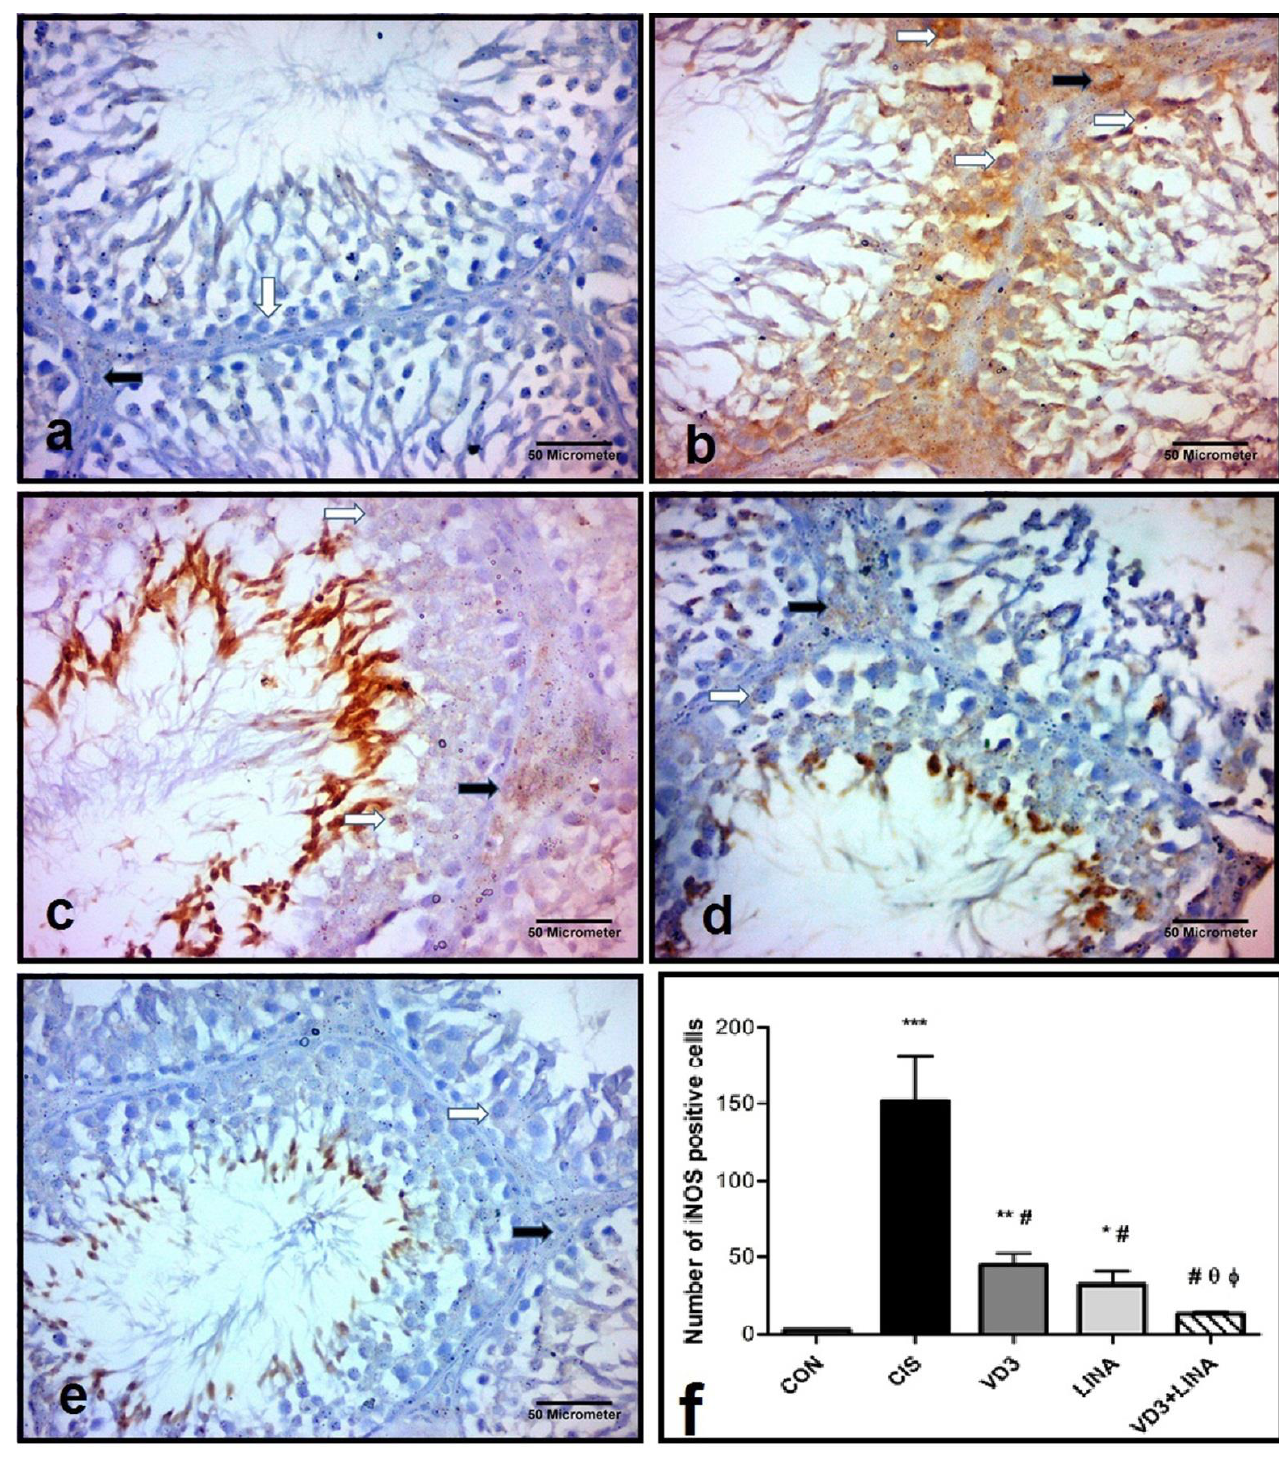
Figure 7. Immunohistochemical staining of iNOS in testicular sections from experimental groups. iNOS immunoreactivity appeared as brown cytoplasmic staining; (avidin biotin peroxidase stain with Hx counter stain x400, scale bar = 50 μm); ( a ): CON group showing scanty immunoexpression of iNOS within the spermatogenic cells (white arrows) and interstitial cells of Leydig (black arrow); ( b ): CIS group showing marked expression of iNOS within the spermatogenic cells (white arrows) and interstitial cells of Leydig (black arrow), compared to control group; ( c ): VD3 group showing decrease in the expression of iNOS within the spermatogenic cells (white arrows) and interstitial cells of Leydig (black arrow); ( d ): LINA group showing decrease in the expression of iNOS within the spermatogenic cells (white arrows) and interstitial cells of Leydig (black arrow); ( e ): VD3+LINA